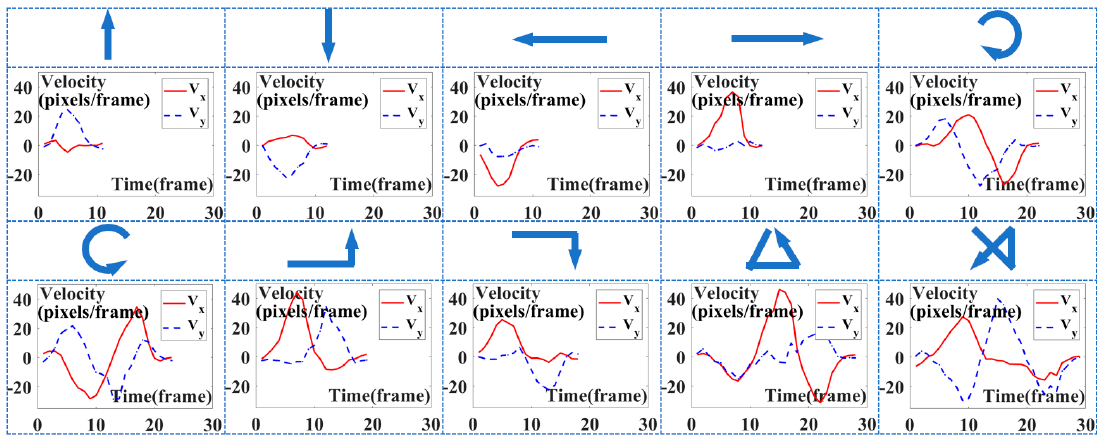
Figure 9. Velocity curves sample of the 10 predefined HMT gestures.